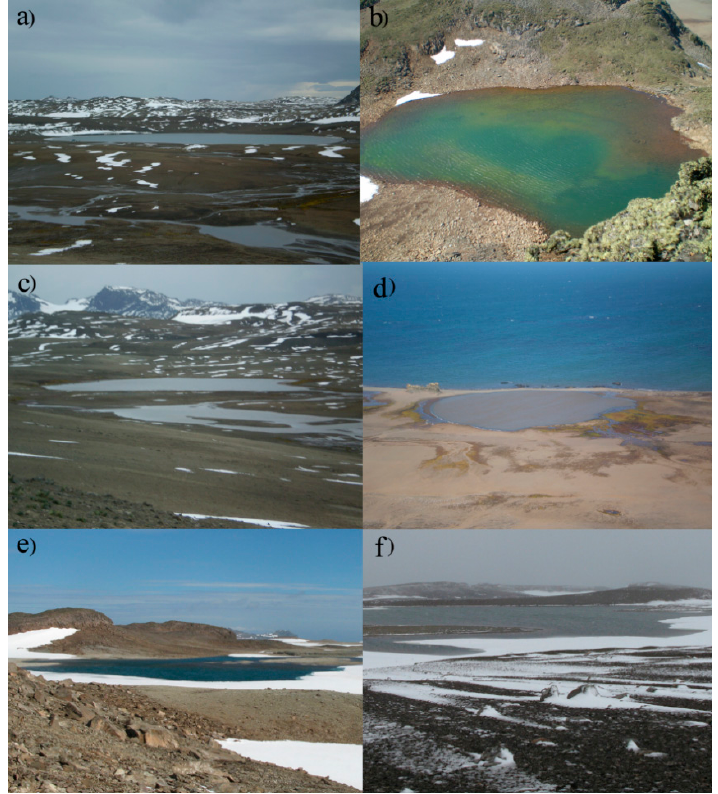
Figure 2. Photographs of some representative lakes from Byers Peninsula: ( a ) Lake Limnopolar; ( b ) Lake Cerro Negro; ( c ) Lake Somero; ( d ) Lake Refugio; ( e ) Lake Turbio; ( f ) Chester Cone Lake.